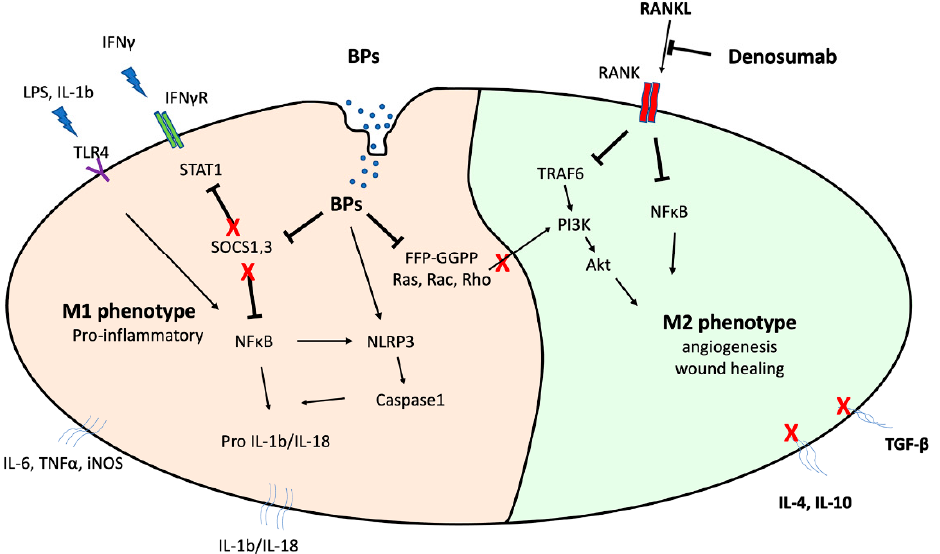
Figure 1. In vitro effects of antiresorptives on macrophage signaling cascades. BPs’ internalization by macrophages results in inhibition of the mevalonate pathway and SOCS1/3 signaling and aug- ments NLRP3 inflammasome activity. Moreover, BPs enhance IFN γ /STAT1 and TLR4 signaling, driving to NF κ B hyper-activity. In addition, downregulation of key mevalonate enzymes inhibits PI3K-dependent M2 polarization. Altogether, BPs favor M1 polarization and contribute to a pro- inflammatory phenotype that results in mature IL1b/IL18 synthesis as well as IL6, iNOS, and TNF α release. Denosumab administration inhibits RANK downstream signaling pathways, including NF κ B- and PI3K/AKT-dependent M2 polarization. (NLRP3, NOD-like receptor proteins 3; SOCS, Suppressors of cytokine signaling; STAT, Signal transducer and activator of transcription; PI3K, Phosphoinositide 3 kinases).